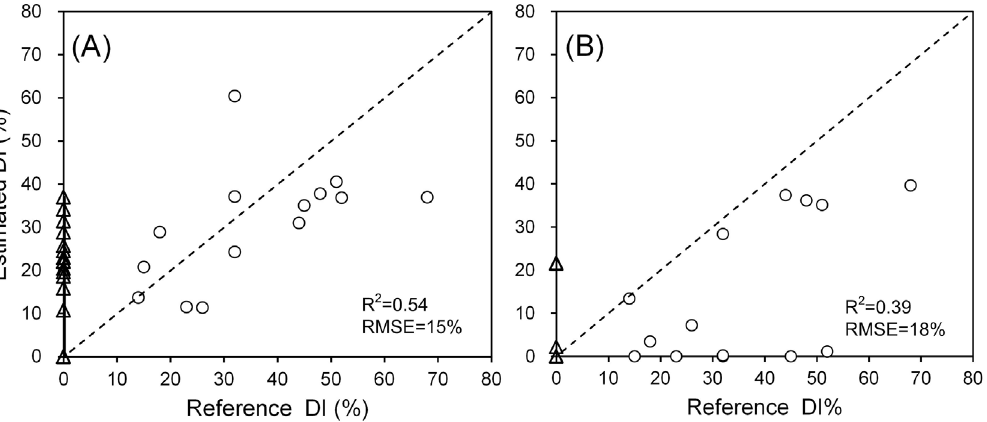
Figure 9. Scatter plots between surveyed DI s (reference) and DI estimates produced by PLSR (A) and MTMF (B). The circle indicates diseased samples whereas the triangle indicates normal samples. The R 2 and RMSE are calculated based on diseased